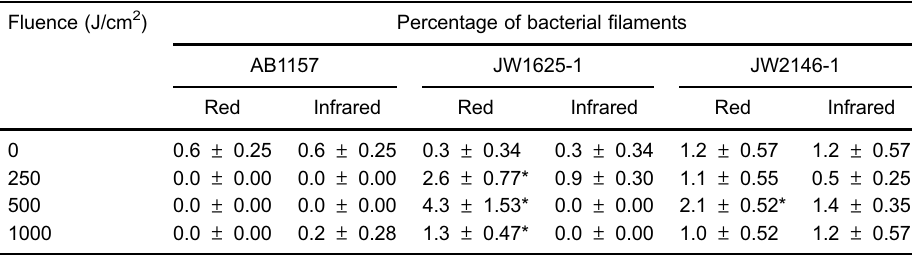
Table 4. Bacterial fi lament percentages in exponentially grown E. coli cultures exposed to low-intensity red and infrared lasers. Fluence (J/cm 2 )